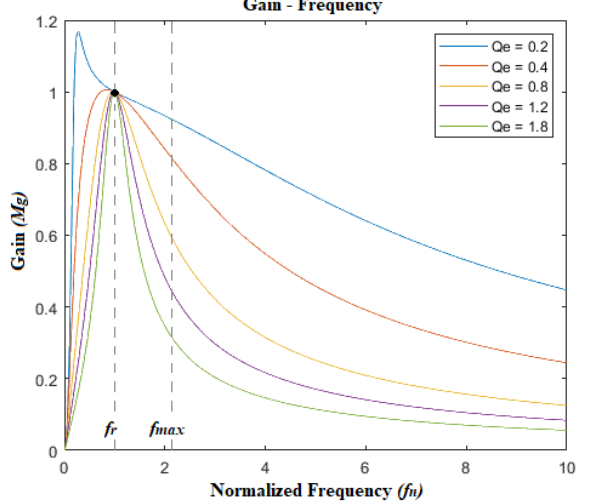
Figure 4. Gain vs. frequency curves of LLC resonant converter. The basic parameters of the designed LLC converter are presented in Table